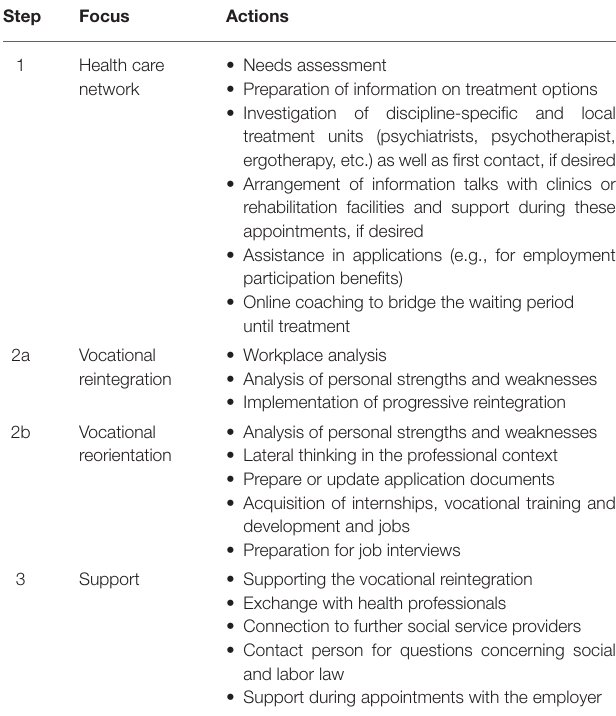
TABLE 1 | Steps of the intervention program of the rehabilitation